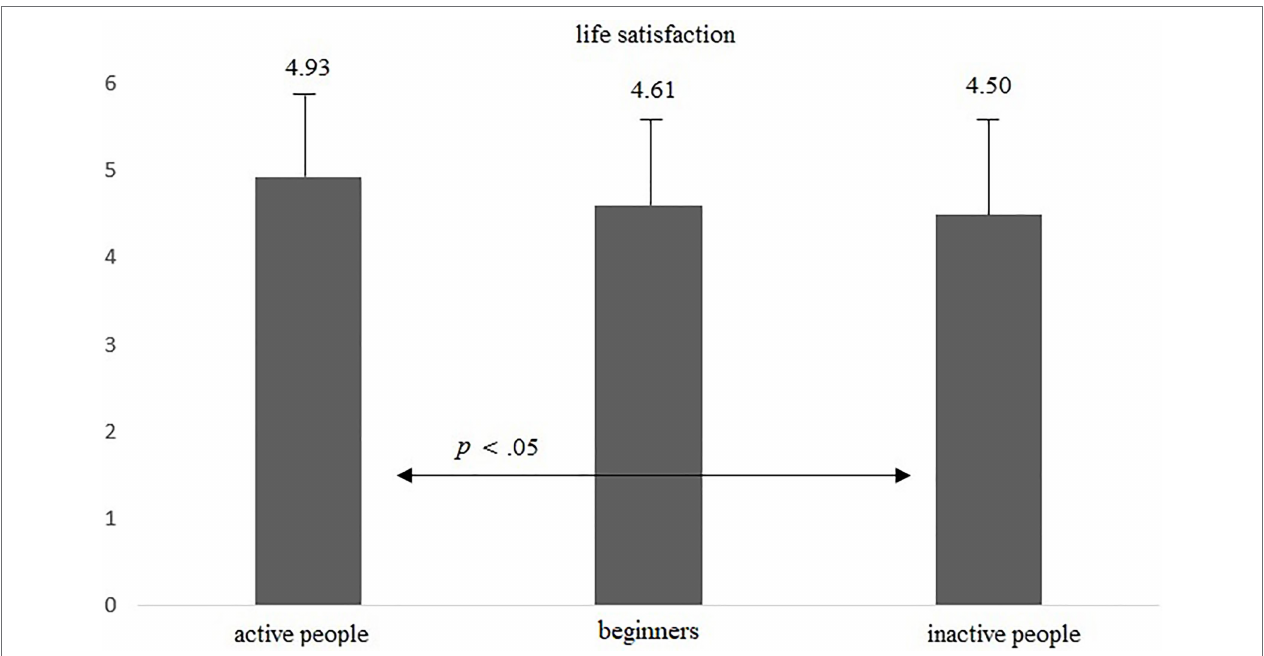
FIGURE 2 | Average level of life satisfaction in groups of active people, beginners, and inactive people.